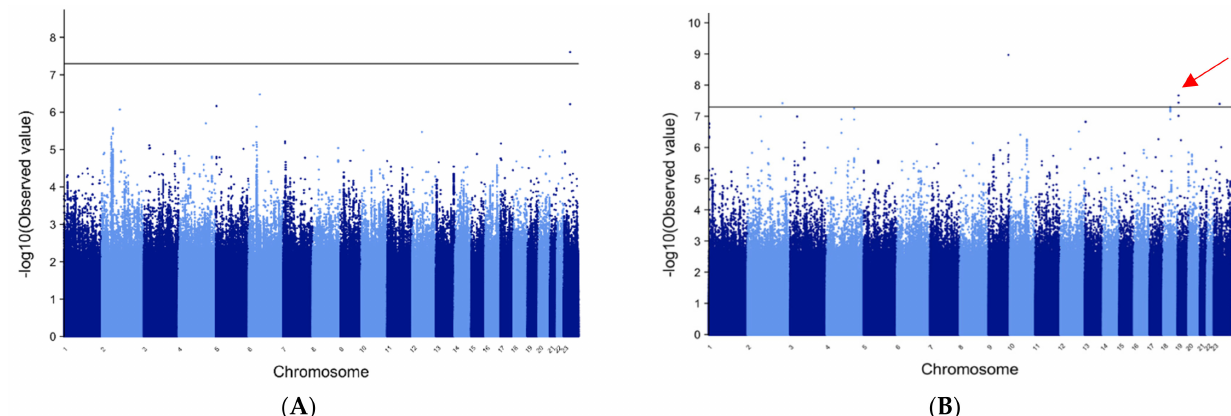
Figure 3. METAL Manhattan plots for focal epilepsy A. Manhattan plots for the METAL analysis of focal epilepsy patients: ( A ) patients of European ancestry; ( B ) patients of African ancestry. Few markers reach levels of statistical significance; however, 12 linked markers in PIKC3 reach levels strongly suggestive of association in the patients of African ancestry (red arrow).